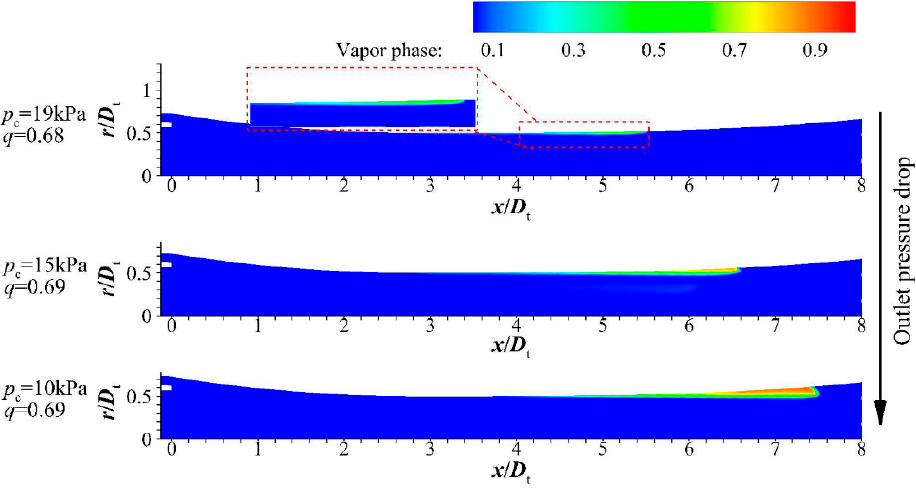
Figure 15. Cavitation development in the SAJP.